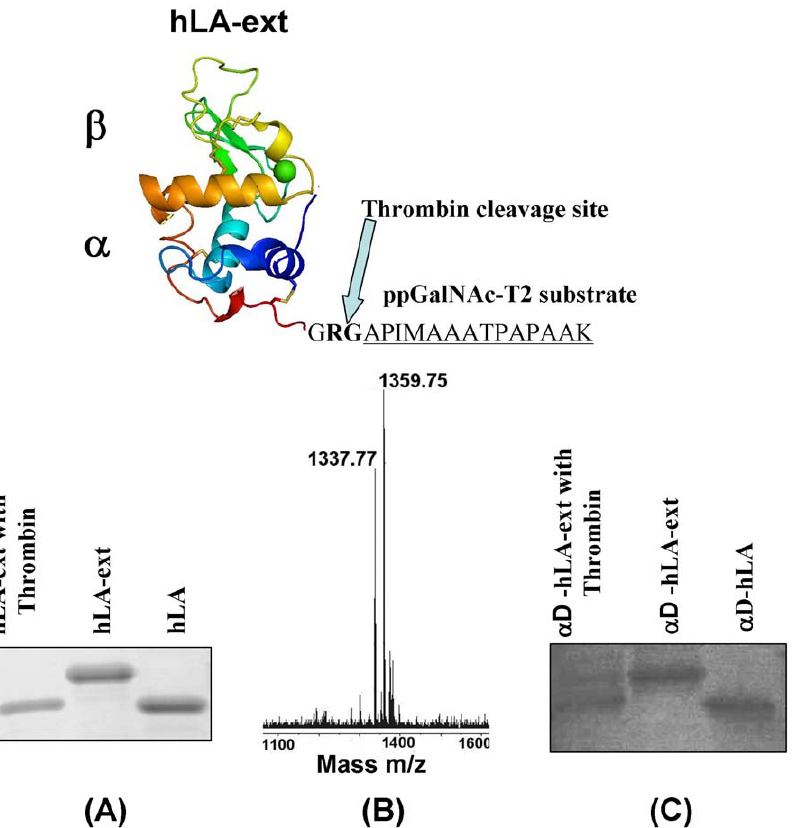
Figure 3. Incorporation of a polypeptide tag to full length hLA and a D-hLA proteins. Schematic representation of the C-terminal extension of 17 amino acids engineered on hLA showing the acceptor Thr residue for the site-specific labeling and the thrombin cleavage site. (A) SDS-PAGE analyses of purified hLA, hLA-ext, with and without thrombin treatment. To confirm the presence of the C-terminal extension peptide, the protein was treated with thrombin. The mobility of hLA-ext treated with thrombin is comparable to wild-type hLA. (B) Since the molecular weight of the released C-terminal polypeptide is only 1337 Da it could not be observed on any SDS-PAGE gel. However, MALDI-TOF spectroscopic analysis of the thrombin treated samples showed a release of a correct molecular weight peptide from the proteins carrying the C-terminal extension peptide. (C) The protein samples a D-hLA and a D-hLA-ext with and without Thrombin treatment were analyzed on SDS-PAGE similar to hLA-ext shown in (A).